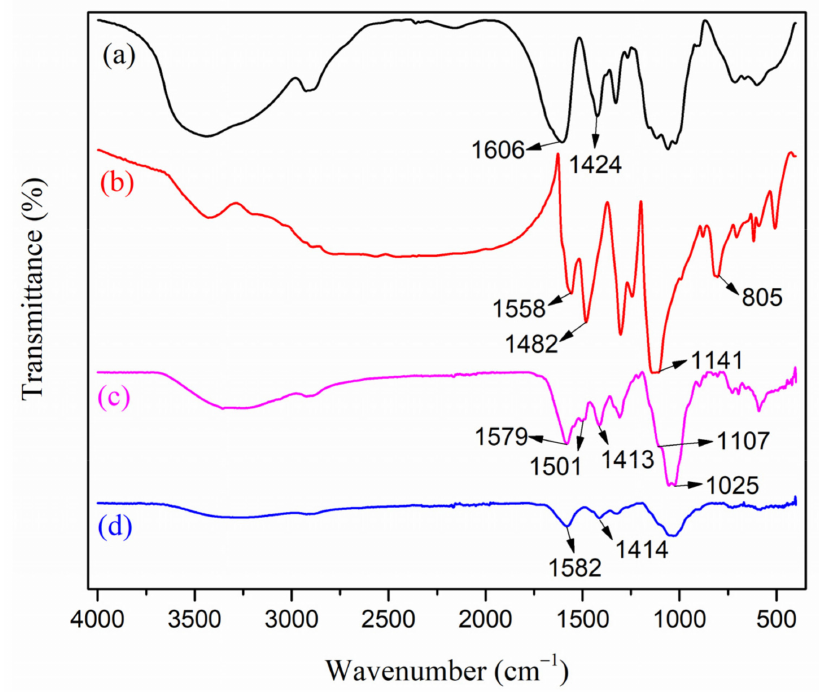
Figure 1. The FT-IR spectra of CMC-Na (a), PANI (b), the obverse side of Cu II/I @CMC-PANI film (c), and the back side of Cu II/I @CMC-PANI film